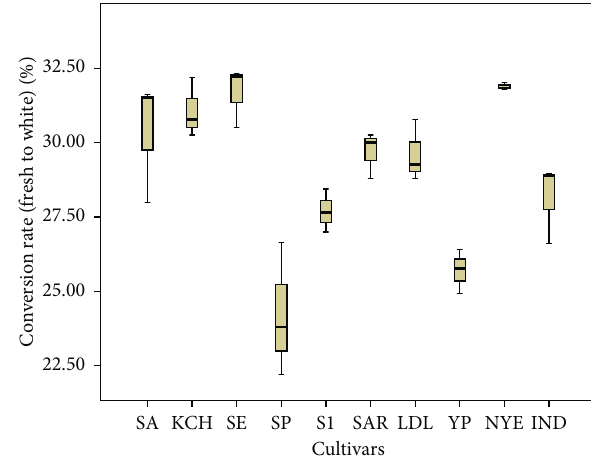
Figure 11: Fruit weight (single berry) (g).